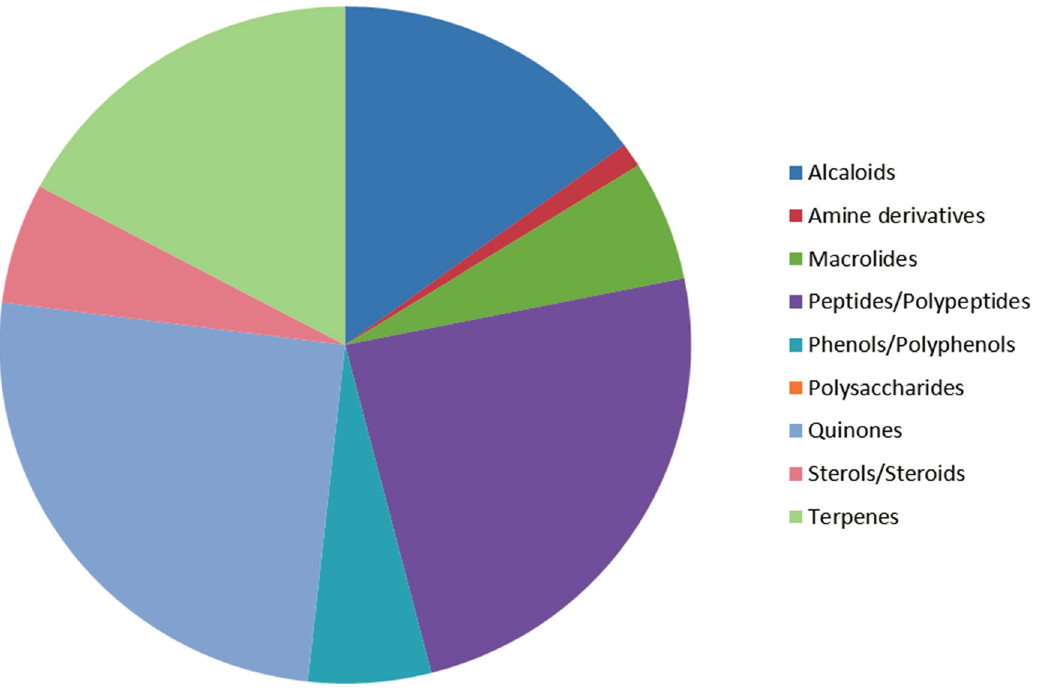
Figure 48. Anticancer compounds regrouped per